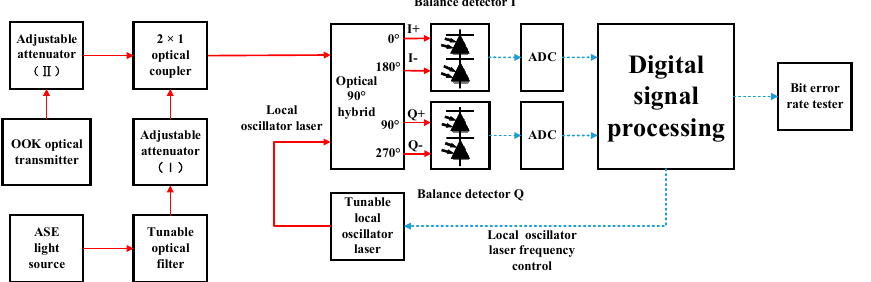
Figure 12. Experimental structure of the influence of AL on OOK coherent reception. In the coherent OOK reception experiment, channels I and Q have the same SNR; thus, the SNR of channel I is equivalent to the SNR of the entire system. This experiment analyzed the SNR of channel I to evaluate the impact of AL. In the experiment, an ASE light source was used to simulate AL. In the following description, we refer to the light output by the ASE light source as the simulated ambient light (SAL). The LO power was 12.8 mW and the corresponding I-channel noise voltage variance